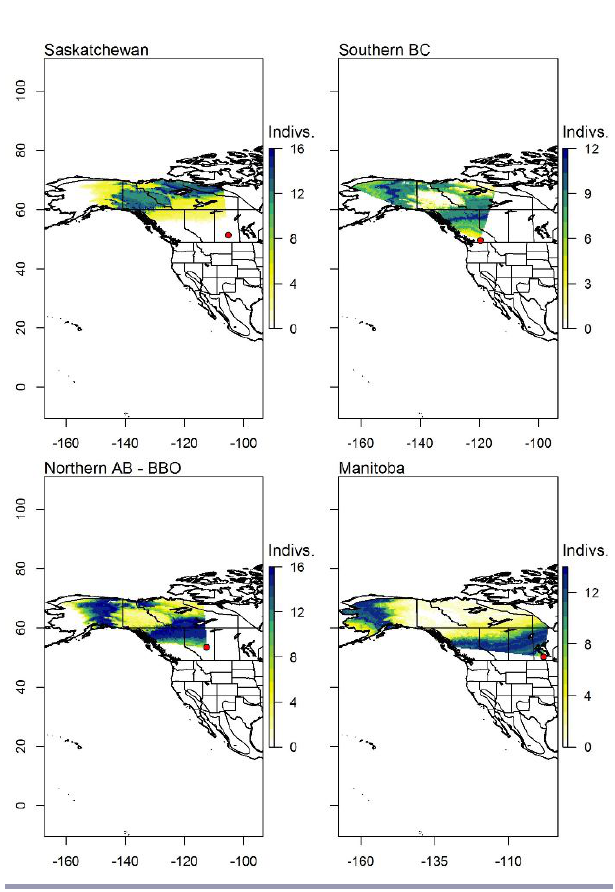
Fig. 7 . Probable origins of Yellow Warblers ( Setophaga petechia ) during fall migration continued. Red dots indicate locations of Canadian Migration Monitoring Network stations used in the analysis. Scales indicate the number of individuals that were isotopically consistent with similarly colored pixels in the map